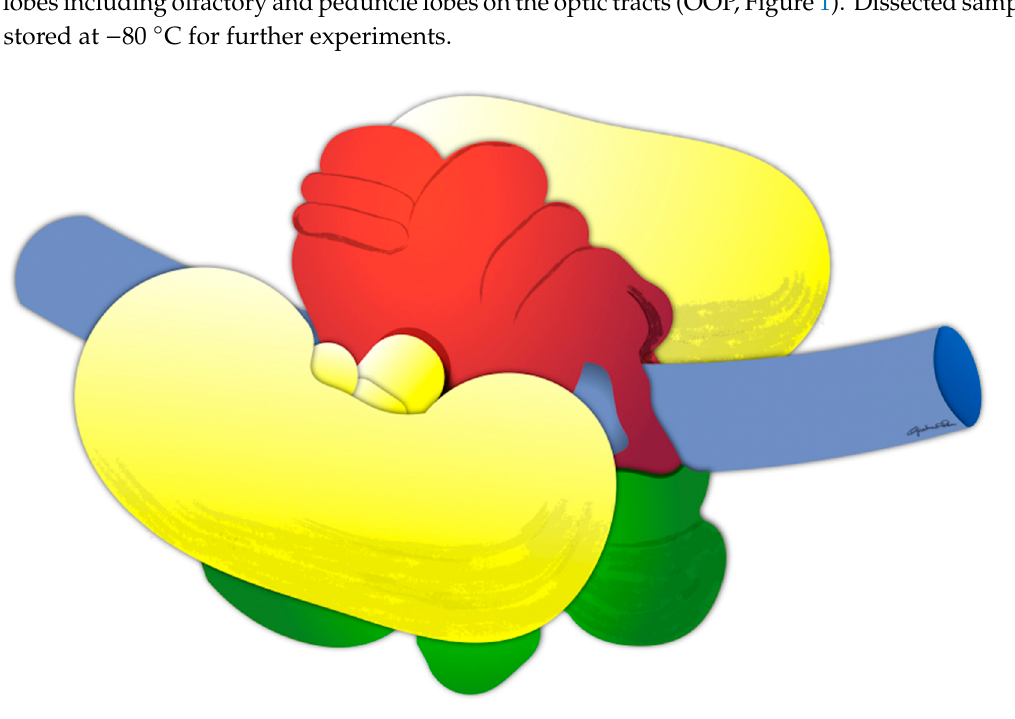
Figure 1. Schematic view of Octopus vulgaris brain anatomy, highlighting the tissues sampled for analysis: the optic lobes with olfactory and peduncle lobes on the optic tracts (OOP, yellow), the central part of the supraesophageal mass (red), and the subesophageal mass (green) that enwraps the esophagus (blue, not analyzed).